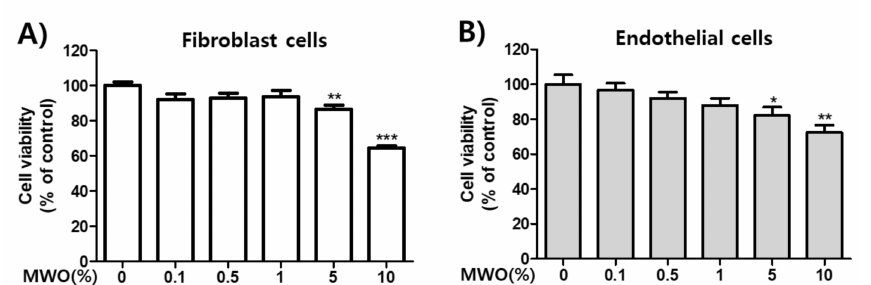
Figure 1. Effect of mealworm oil (MWO) on cell viability in fibroblast and endothelial cells. ( A ) Fibroblast or ( B ) endothelial cells were treated with the indicated concentrations of MWO for 24 h. The viabilities of cells were evaluated by MTT assay. The values are shown as means ± SD. * p < 0.05, ** p < 0.01 and *** p < 0.001 compared to the